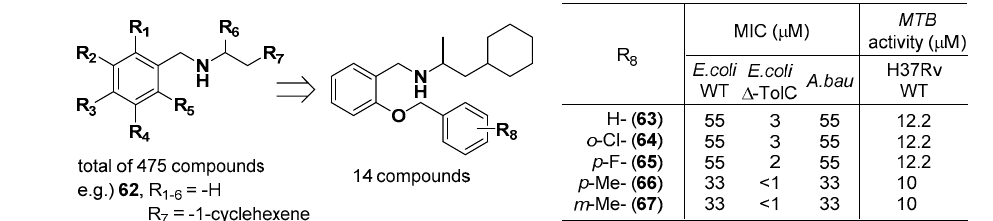
Figure 18. Structures of the secondary benzylamines with antimicrobial activities via prokaryotic phenylalanyl-tRNA synthetase (PheRS) inhibition.